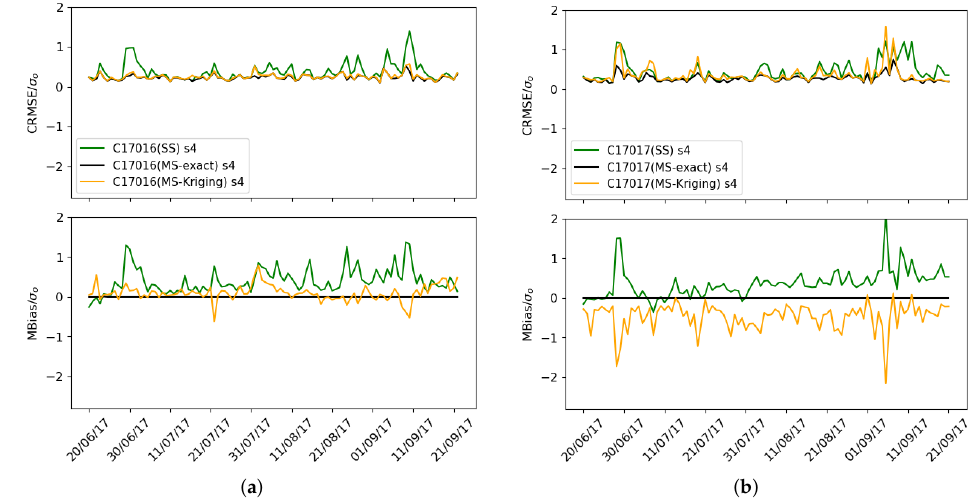
Figure 16. Case 3: Mean normalized bias and normalized CRMSE, single-scale (green), multi-scale with exact correction (black) and multi-scale with Kriging estimates (orange), ( a ) Captor 17016 (Vic), ( b ) Captor 17017